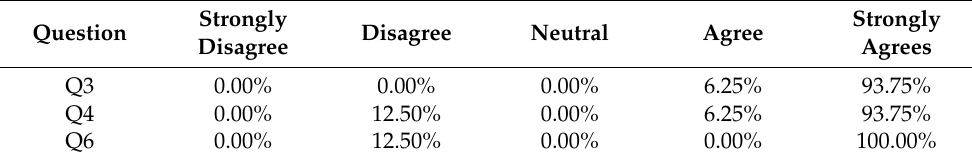
Table 4. Q3, Q4, Q6—Hypothesis 1 and 2.